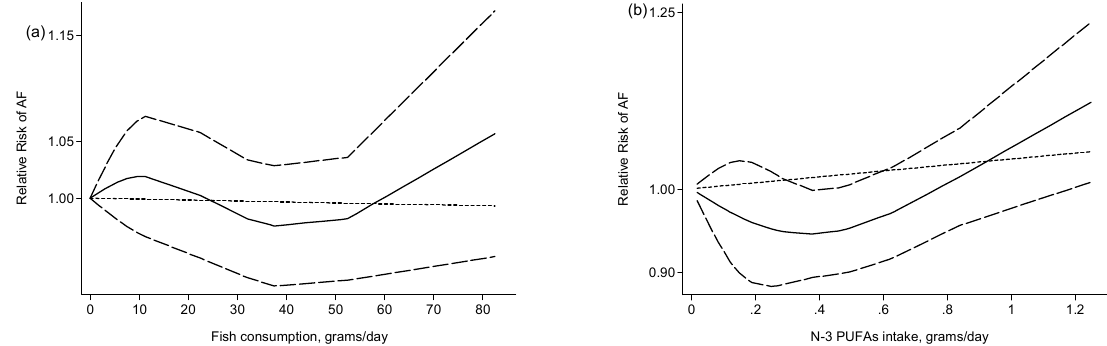
Figure 4. Restricted cubic spline random-effects meta-analysis evaluating potential nonlinear relationships between fish consumption ( a ) and n -3 PUFAs intake ( b ) and atrial fibrillation risk. The solid, dashed and dotted lines represent relative risk, 95% confidence interval and estimated linear trends, respectively.